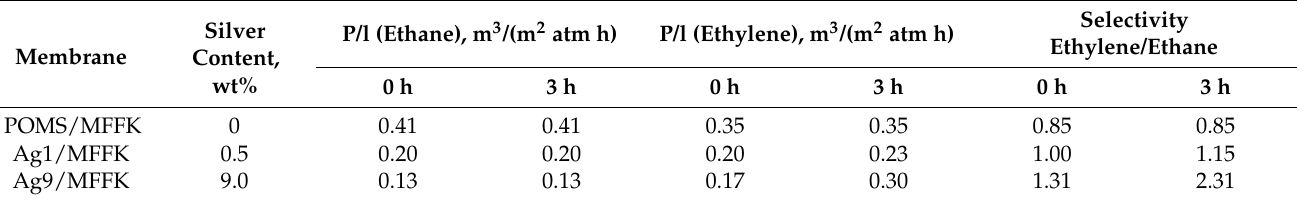
Table 3. Gas transport properties of POMS/MFFK, Ag1/MFFK, and Ag9/MFFK membranes in the separation of a binary ethylene/ethane mixture before and after exposure to a gas mixture